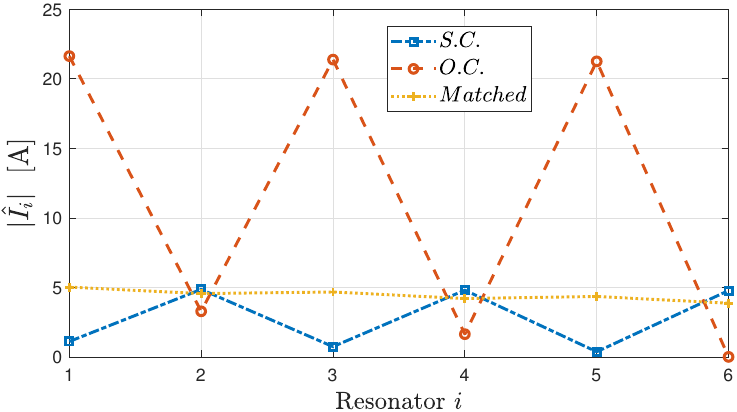
Figure 4. Current standing wave patterns for different termination